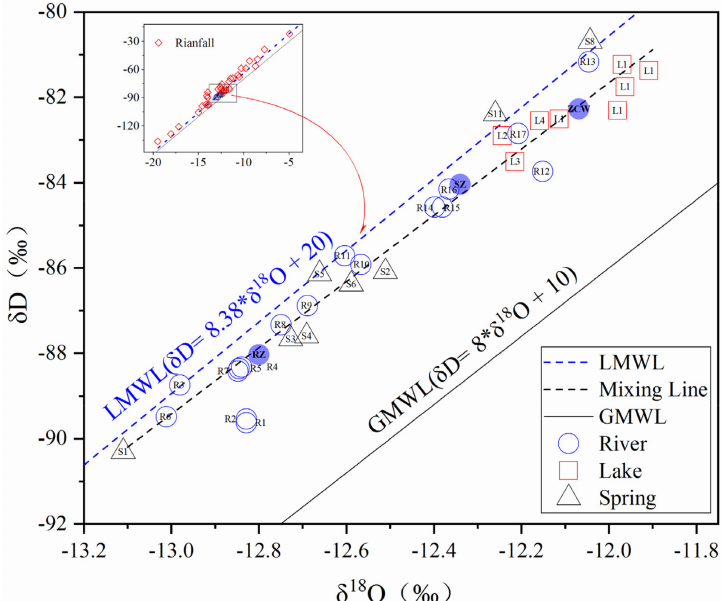
Figure 6. Stable isotopes of rainfall, spring, lake, and river water in Jiuzhaigou. The solid circle represents the isotopic average value of three valleys. Changhai Lake (L1) water was sampled many